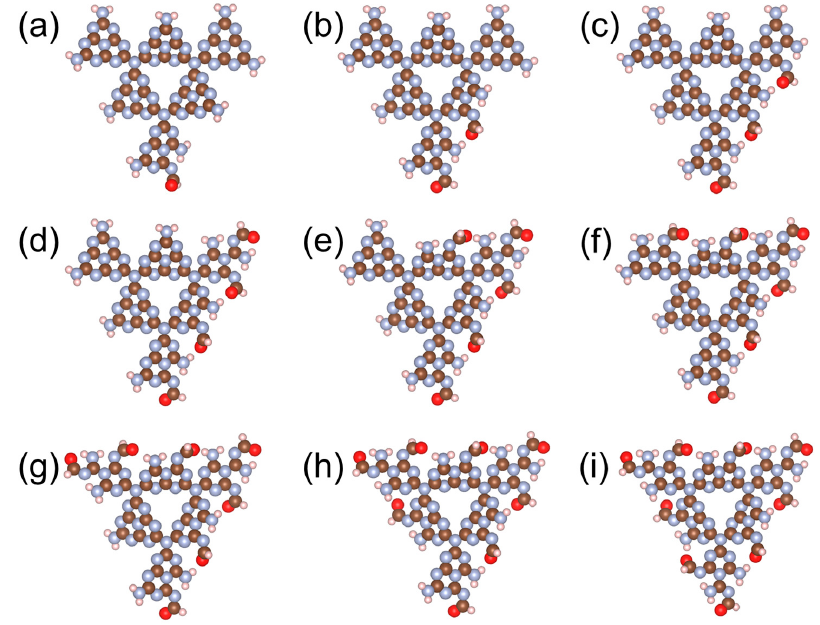
Figure 4. Structures of g-C 3 N 4 -6 with varying numbers of C=O groups. Brown, blue, pink, and red spheres represent C, N, H, and O, respectively. Nanomaterials 2018 , 8 , x FOR PEER REVIEW